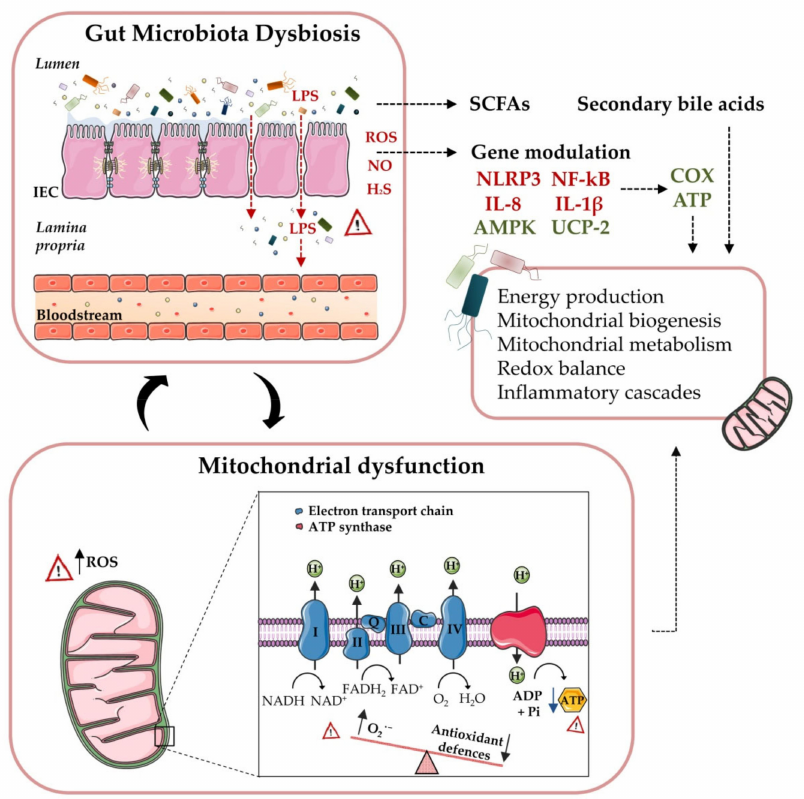
Figure 3. Microbiota-mitochondria inter-talk: Increased gut permeability in obese and T2D patients can induce LPS translocation to the bloodstream, along with a further inflammatory cascade, ROS and H 2 S production, as well as inflammasome NLRP3 activation, thus resulting in a mitochondria-mediated inflammatory response. The inhibition of AMPK activation and decreased expression of UCP-2 lead to a reduced glucose metabolism and to the partial uncoupling of mitochondrial oxidative phosphorylation, as well as an increased ROS production. Moreover, microbiota-released metabolites can also undermine or promote mitochondrial biogenesis and energy metabolism. Concurrently, mitochondrial ROS production can regulate gut microbiota activity and composition by modulating mucosal immune responses and intestinal barrier functions. Abbreviations: AMPK, AMP-activated protein kinase; ATP, adenosine triphosphate; COX, cyclooxygenase; H 2 S, hydrogen sulphide; IEC, intestinal epithelial cells; LPS, lipopolysaccharide; NLRP3, inflammasome NOD-like receptor family and pyrin domain containing 3; NF- κ B, nuclear factor kappa-light-chain-enhancer of activated B cells; NO, nitrogen oxide; ROS, reactive oxygen species; SCFAs, short-chain fatty acids and UCP-2, uncoupling protein